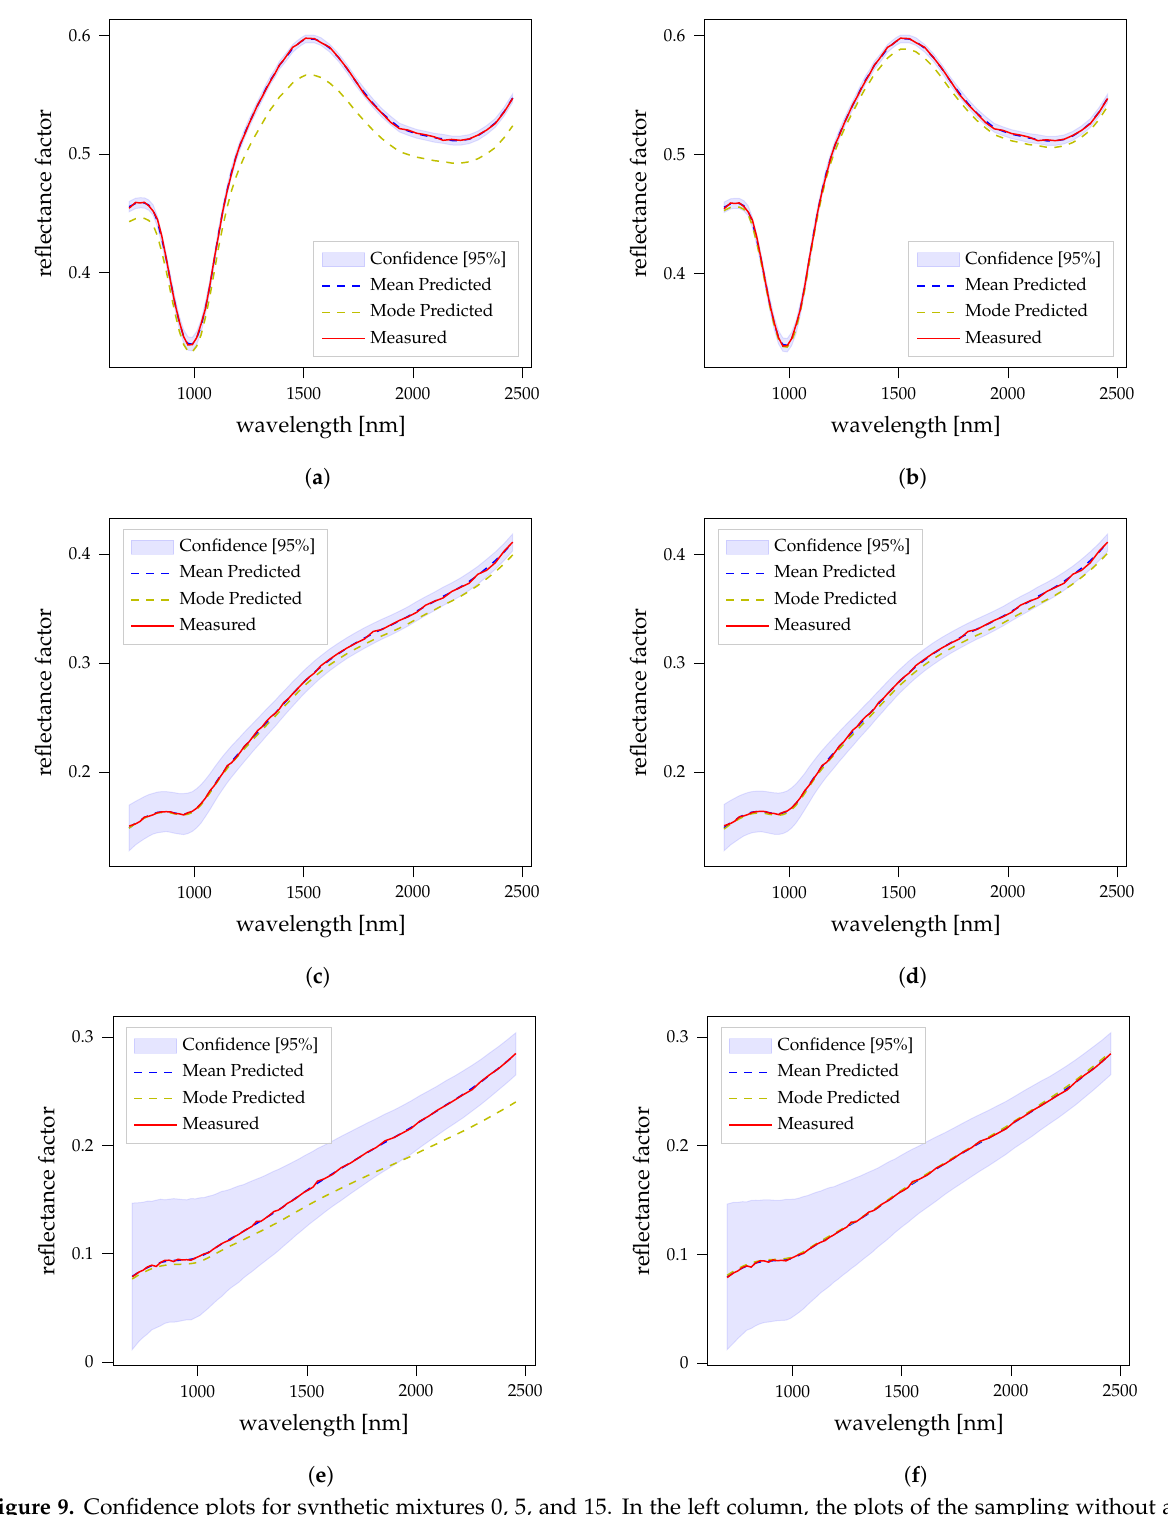
Figure 9. Confidence plots for synthetic mixtures 0, 5, and 15. In the left column, the plots of the sampling without an elemental prior are displayed. For the confidence plots in the right column, prior information about the elements TiO 2 and Al 2 O 3 was included. ( a ) Without elemental prior (mix 0 ); ( b ) With TiO 2 and Al 2 O 3 prior (mix 0 ); ( c ) Without elemental prior (mix 5 ); ( d ) With TiO 2 and Al 2 O 3 prior (mix 5 ); ( e ) Without elemental prior (mix 15 ); ( f ) With TiO 2 and Al 2 O 3 prior (mix 15